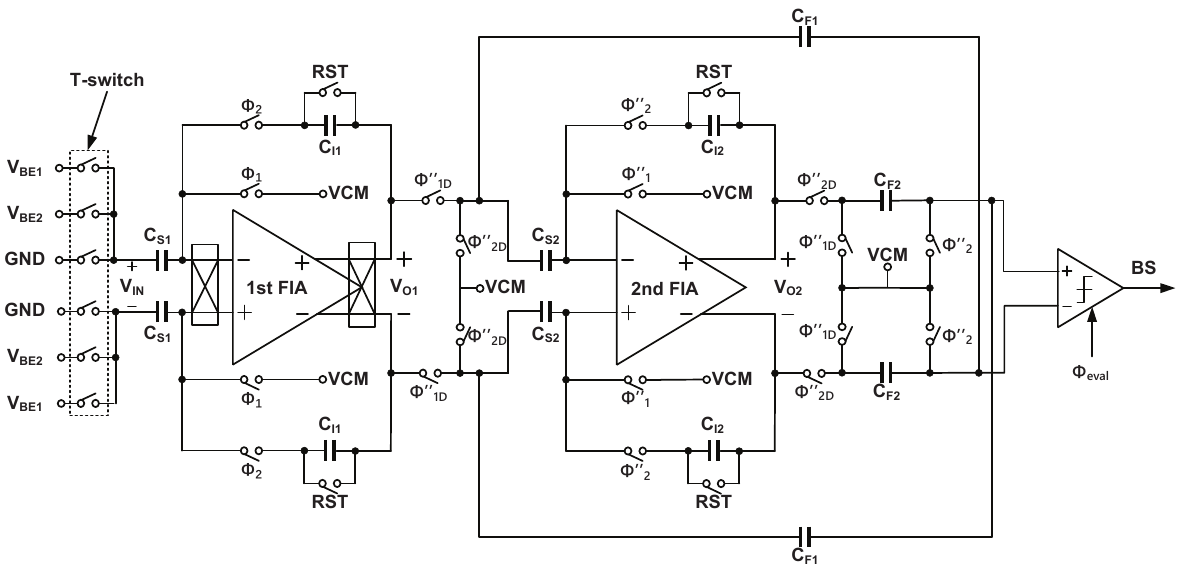
Figure 7. Schematic of the incremental ∆ - Σ